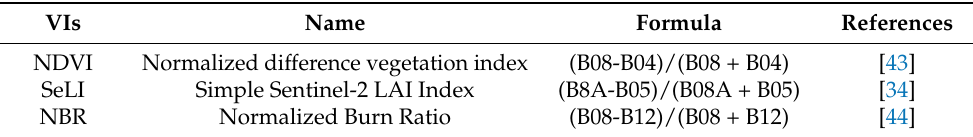
Table 2. Vegetation Indices